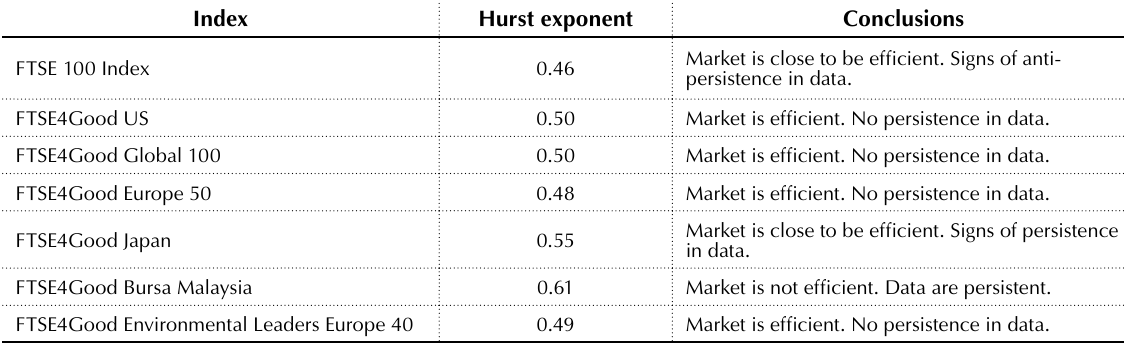
Table 4. Overall results of the Hurst exponent calculations for the FTSE4Good Global Index and traditional FTSE 100 Index *